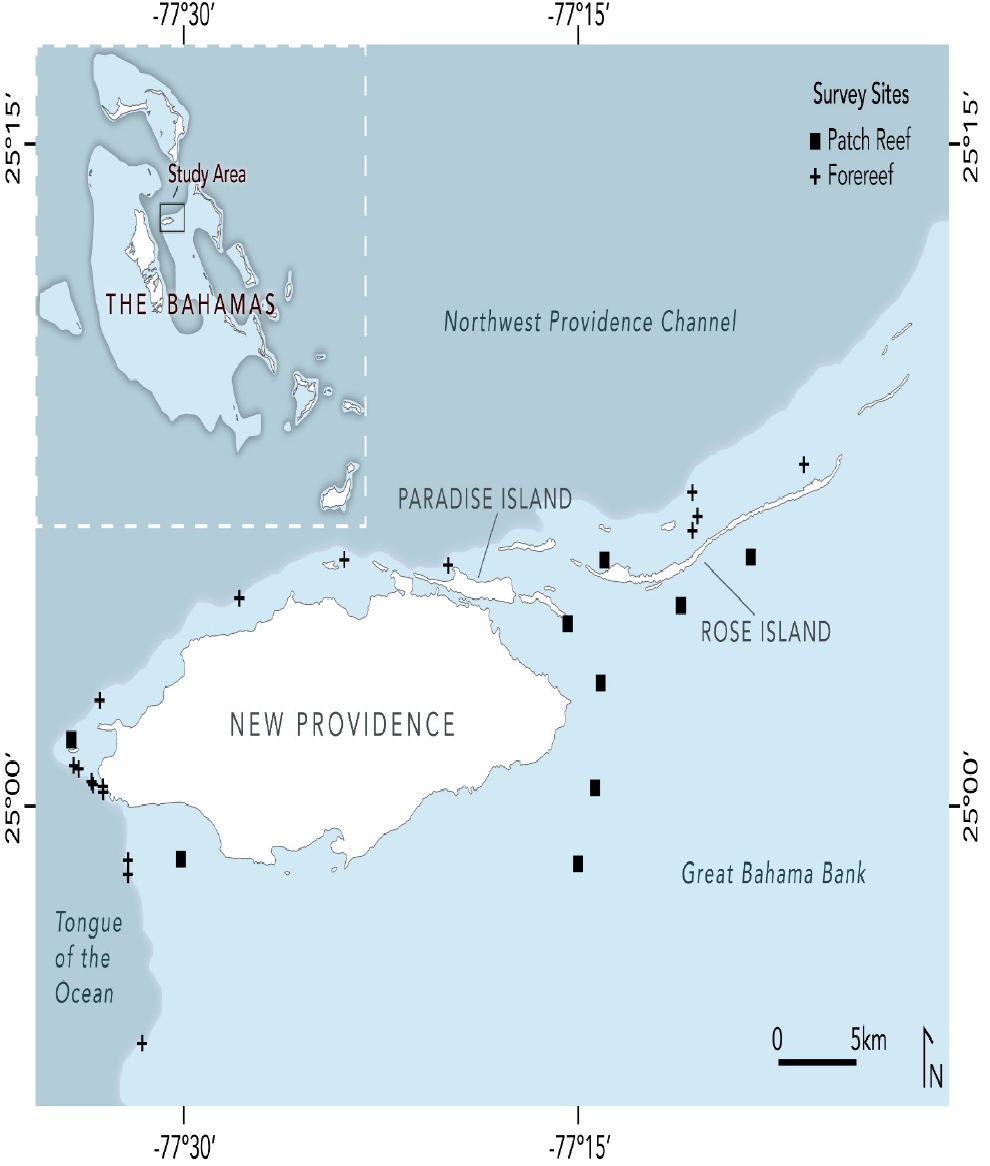
Figure 1. Map of the reef sites (black symbols) surveyed around New Providence and Rose Island in The Bahamas between 2011 and 2019. The inset map shows the location of the study area—New Providence (highlighted in the black box) relative to other Bahamian islands. Reef zones are indi- cated as follows: patch = black squares and forereef = black crosses.